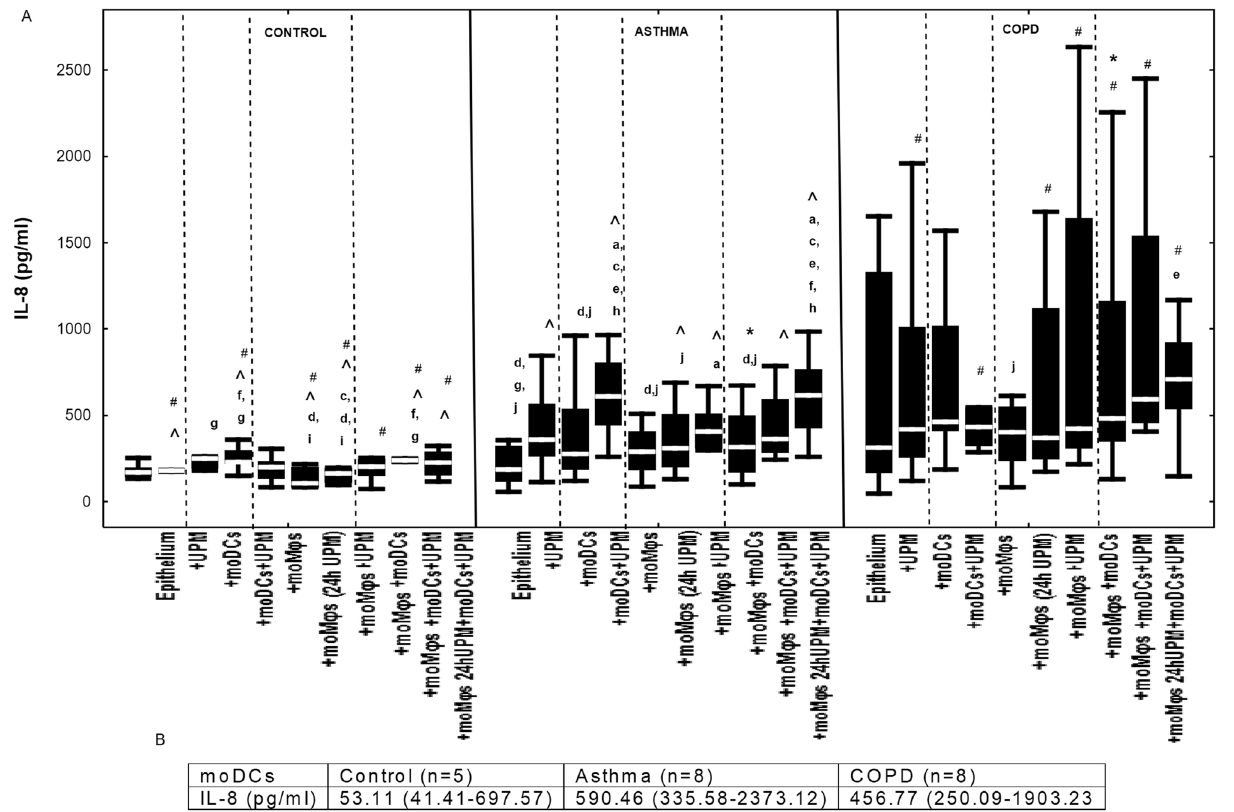
comparison to: a—epithelium, b—epithelium + UPM, c—epithelium + moDCs, d—epithelium + moDCs + UPM, e—epithelium + moMφs, f—epithelium + moMφs (24 h UPM), g- epithelium + moMφs + UPM,